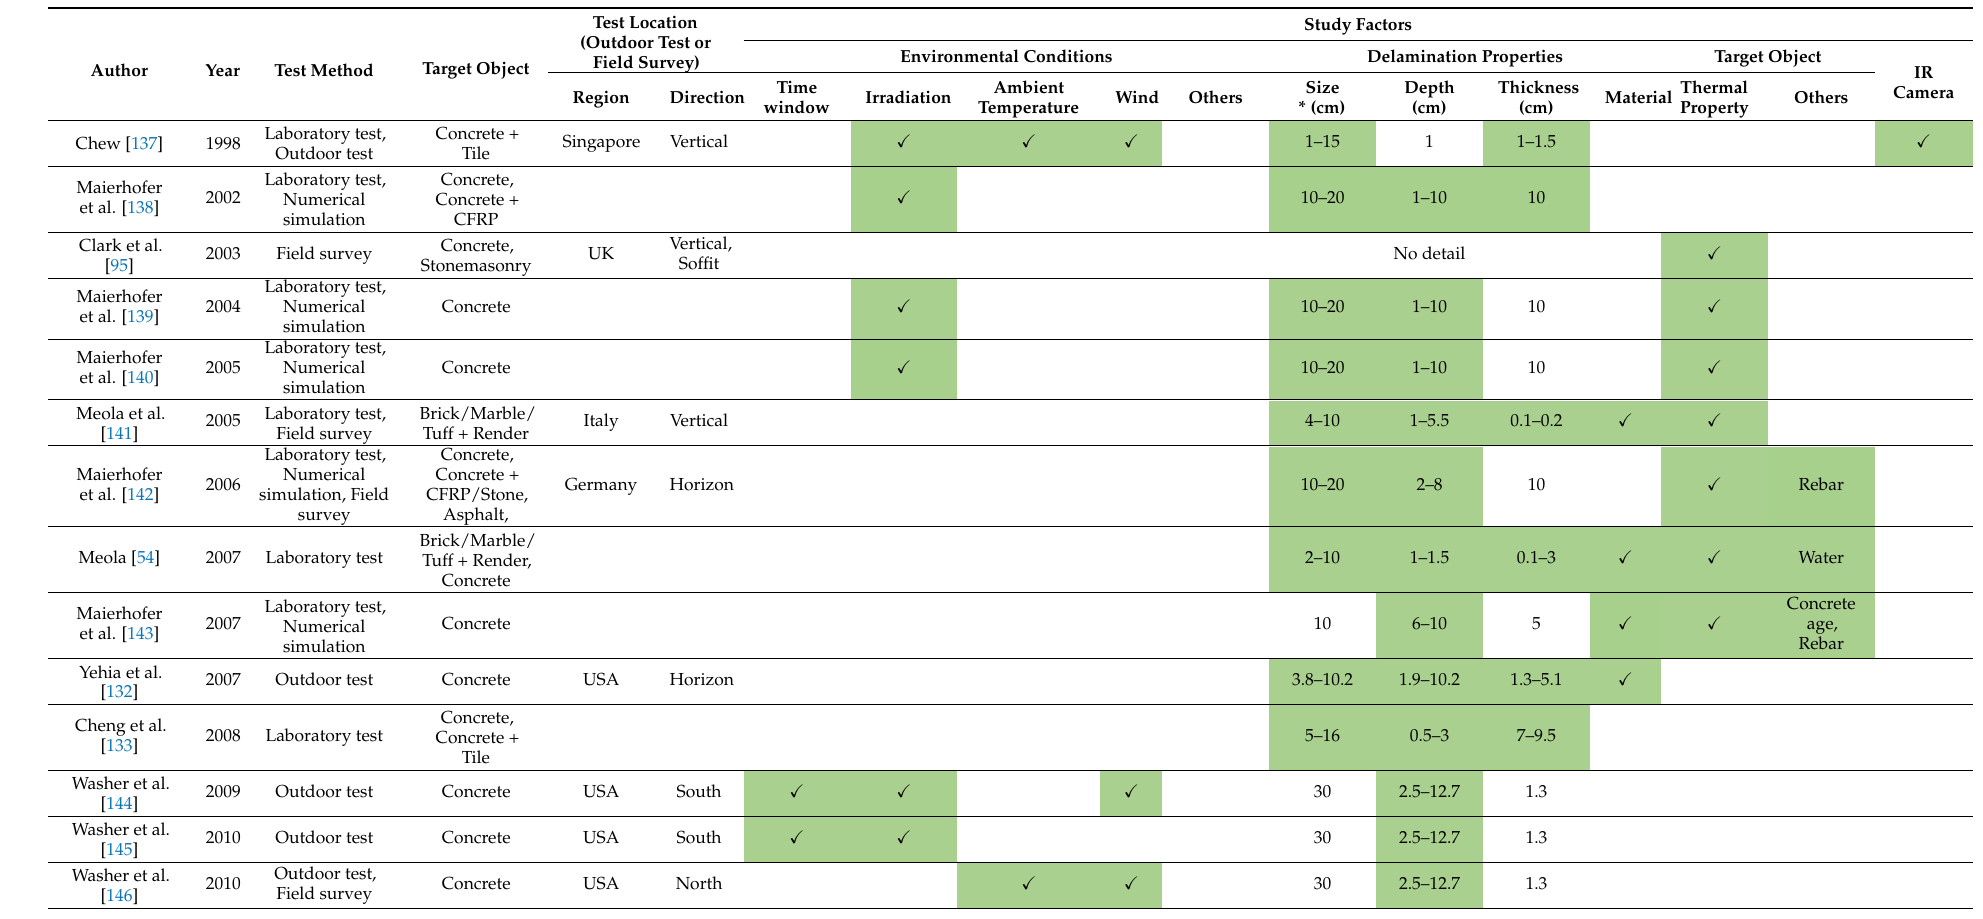
Table 2. Recent studies on affecting factors of delamination detectability of IRT for infrastructures and